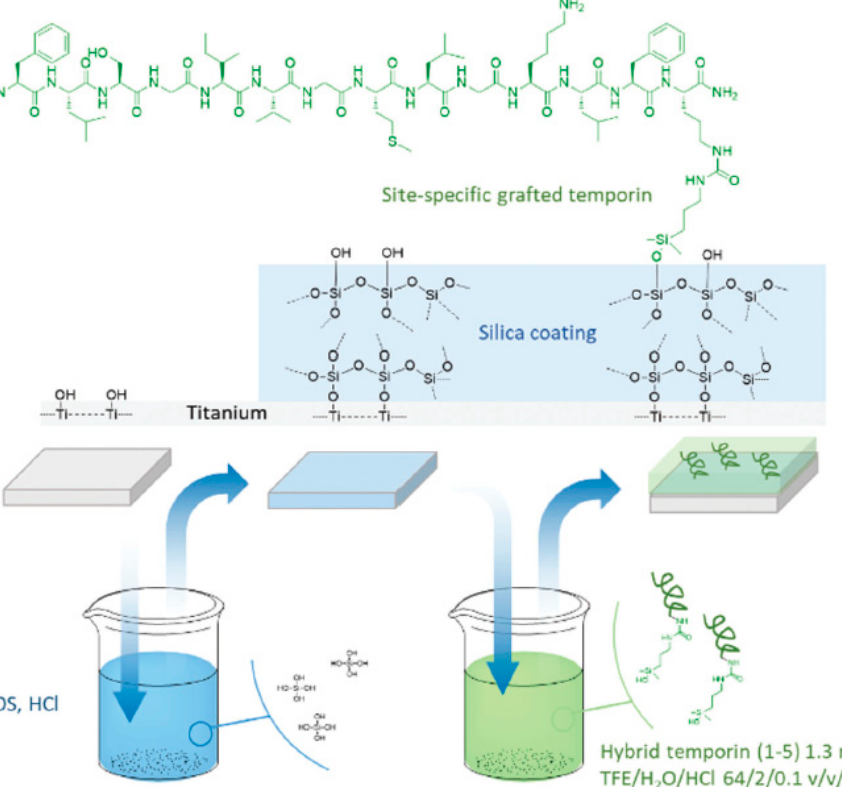
Figure 15. Example of site-specific grafting of hybrid temporin 1 on titanium surfaces. Temporins were modified at their C-ter end by a silanol group that enables the direct grafting onto TEOS precursor. Reproduced from [79]. Copyright © The Royal Society of Chemistry 2018.